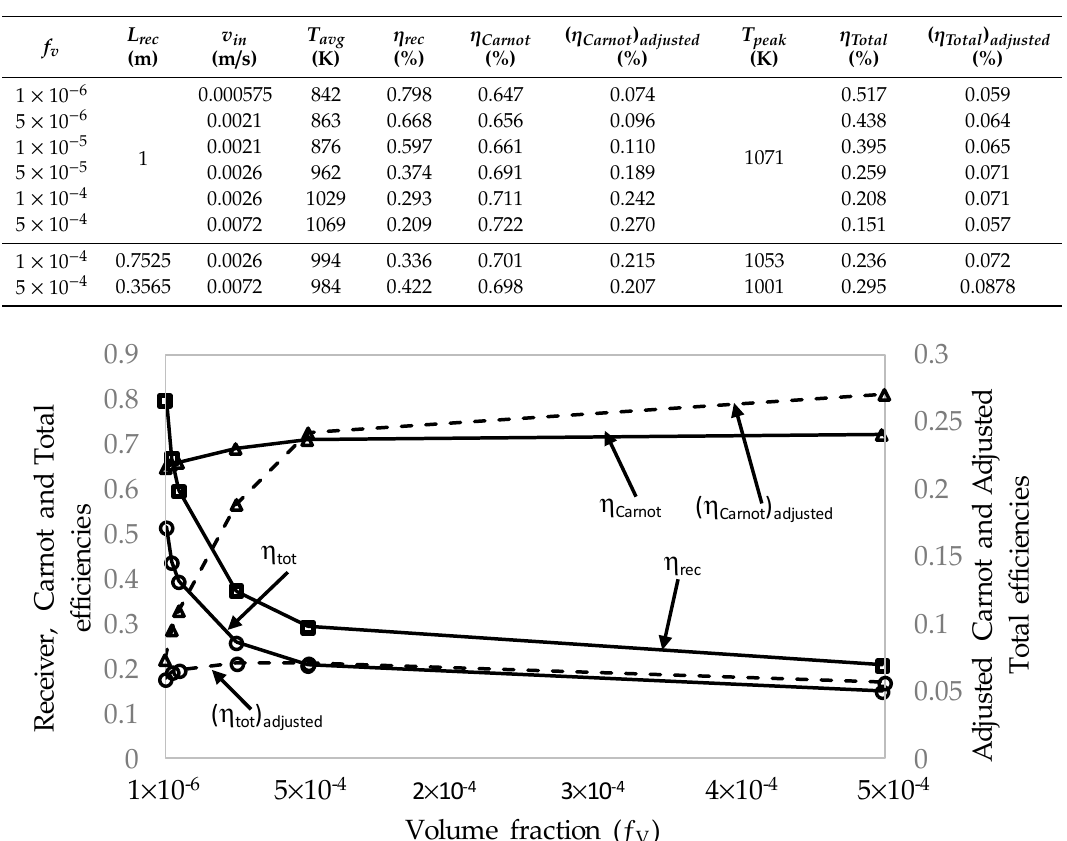
Figure 14. E ffi ciencies ( η ) for di ff erent volume fractions, f v , at a fixed peak temperature, T peak = 1071 K, Figure 14. Efficiencies ( η ) for different volume fractions, f v , at a fixed peak temperature, T peak = 1071 K, and maximum receiver length, L max = 1 and maximum receiver length, L max = 1 m.